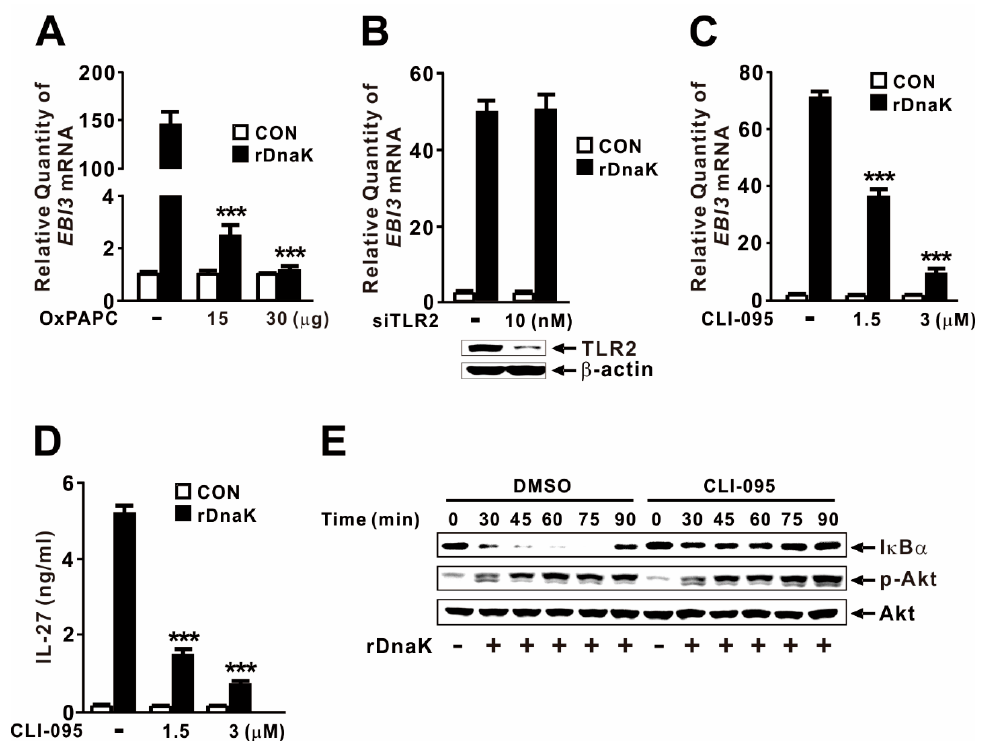
Figure 6. DnaK-mediated induction of EBI3 is partly under the control of TLR4. ( A ) dTHP-1 cells were pretreated with OxPAPC at the indicated concentrations for 1 h, followed by treatment with rDnaK (1 μ g/mL) for 4 h. ( B ) dTHP-1 cells were transfected with 10 nM TLR2 siRNA (siTLR2). Twenty-four hours post-transfection, the transfected cells were treated with rDnaK (1 μ g/mL) for 4 h. The effect of siRNA was verified by immunoblotting for TLR2 protein. ( C , D ) dTHP-1 cells were pretreated with CLI-095 at the indicated concentrations for 1 h, followed by treatment with rDnaK (1 μ g/mL) for 4 h. ( E ) dTHP-1 cells were pretreated with 3 μ M CLI-095, followed by treatment with rDnaK (1 μ g/mL) for the indicated times. After treatment, mRNA levels of EBI3 were measured by qRT-PCR ( A – C ), and protein levels were measured by ELISA ( D ) or immunoblotting ( E ). Data in ( A – D ) are expressed as means ± SD ( n = 3). Data in ( E ) are representative of three separate experiments. ***, p < 0.001 vs. no treatment with inhibitor.